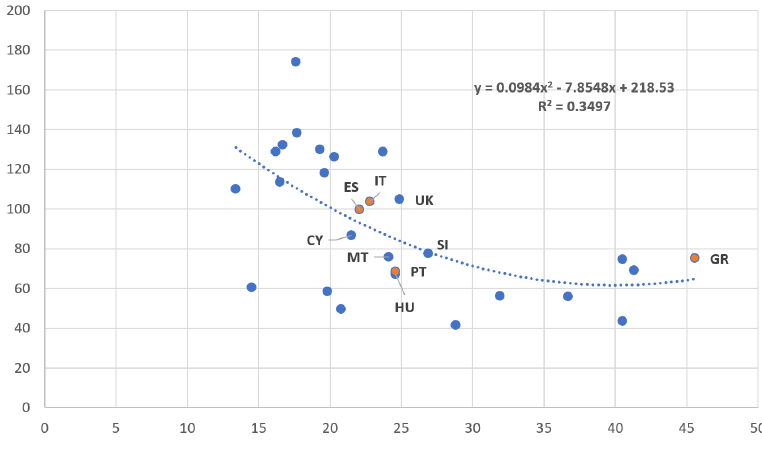
Figure 4: Relation between productivity ( y -axis) and overloaded workers ( x -axis), 2010